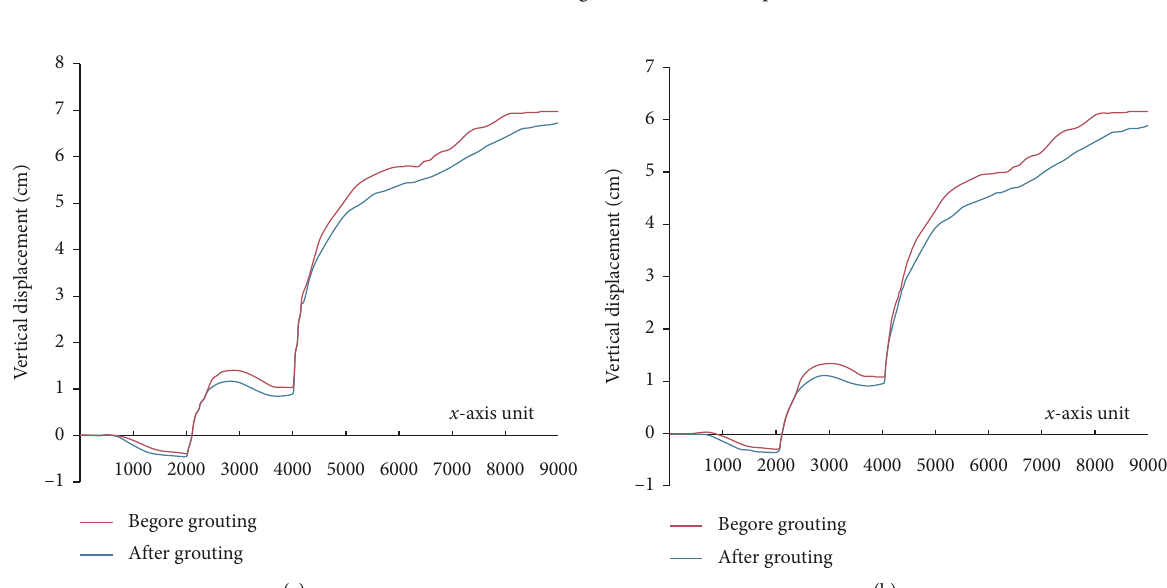
Figure 13: Schematic diagram of excavation process.